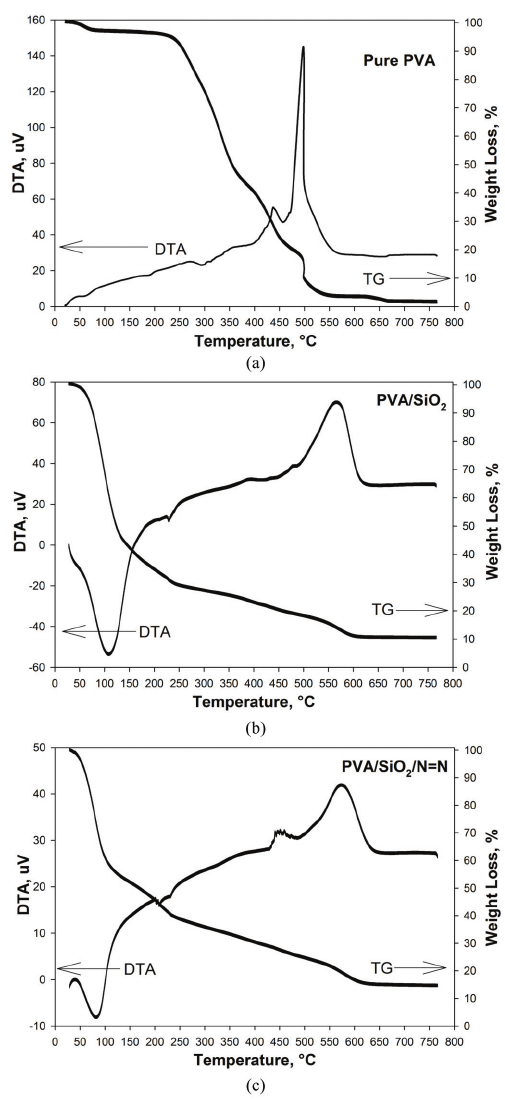
Figure 4. TG-DTA curve of the (a) PVA, (b) PVA-SiO (c)